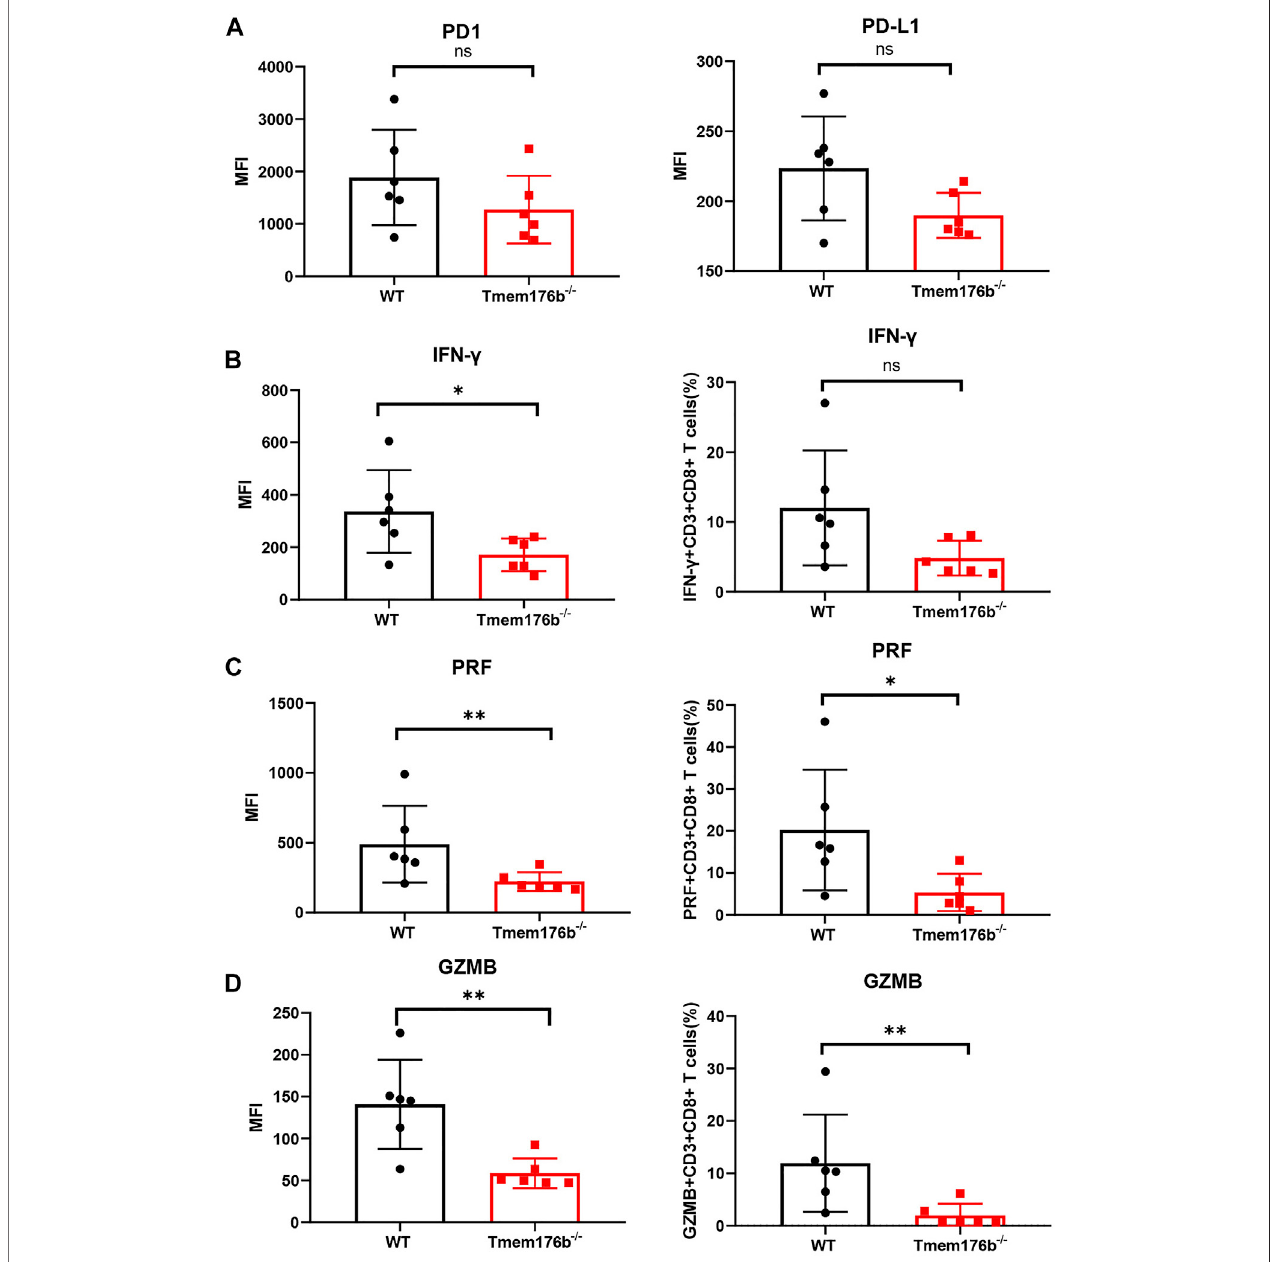
FIGURE 6 | The regulatory effect of Tmem176b on T cells after tumor implantation. (A) The expression level of PD1 and PD-L1 of tumor-in fi ltrating CD8 + T lymphocytes (TIL CD8 + Tcells) from WT and Tmem176b − / − mice( n = 6). (B – D) The MFI (left row) level of IFN- γ , PRF and GZMB of TIL CD8 + Tcells, and frequency (right row) of IFN- γ + , PRF + or GZMB + (among TIL CD8 + T cells) from mice as in (A) ( n = 6). Each symbol represents a single mouse; data are mean SD from six independent samples. ns, not signi fi cant (two-tailed unpaired Student ’ s t test). * p < 0.05, ** p < 0.01, and *** p < 0.001.